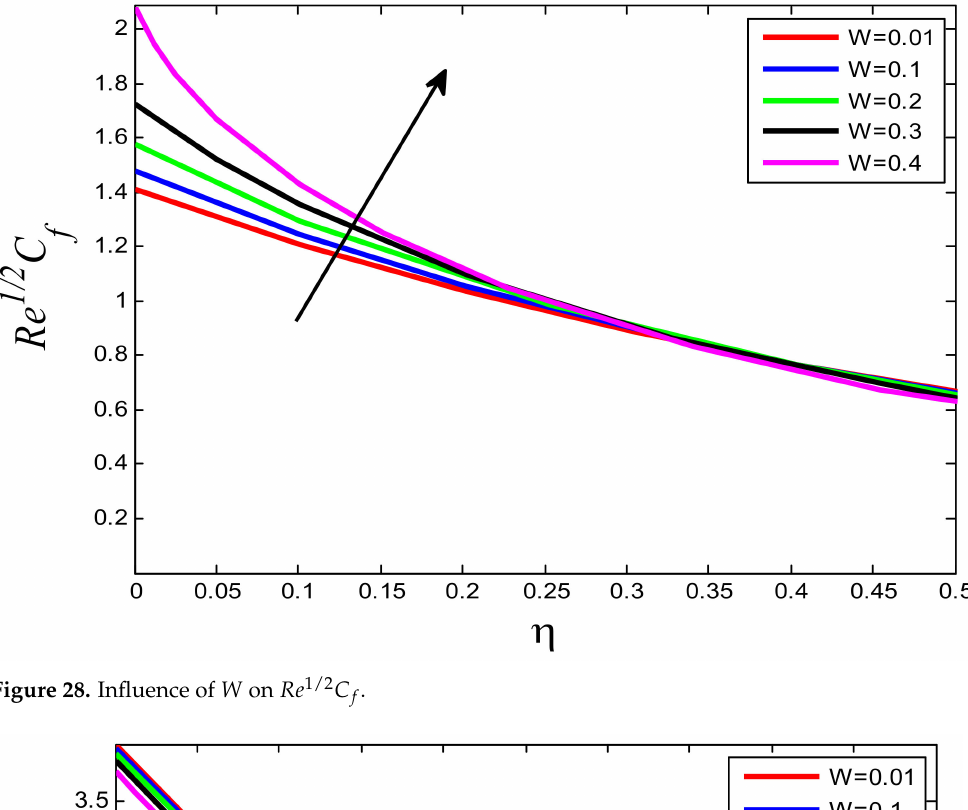
Figure 28. Influence of W on Re 1/2 C f .